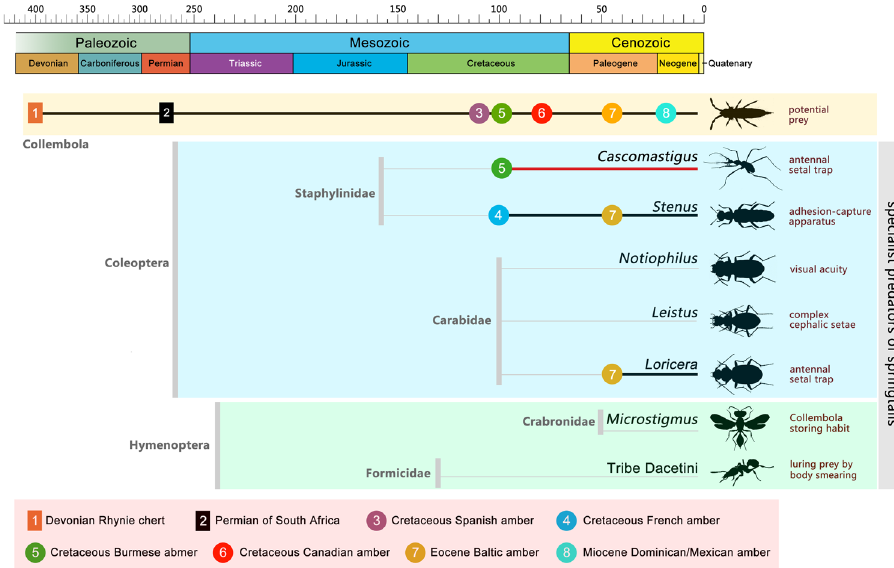
Figure 4. Time-dated chronogram of specialist predators of Collembola in various insect groups. Their respective predatory strategies are provided at the